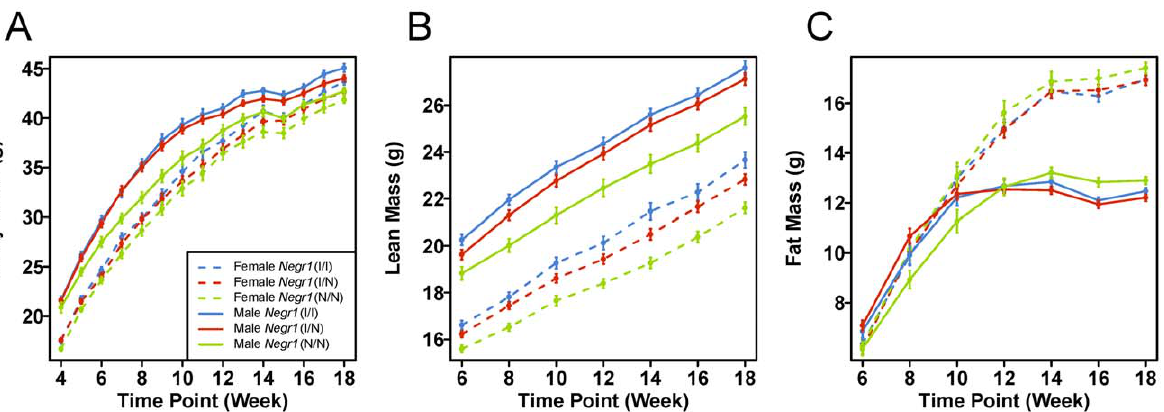
Figure 3. Negr1 -I87N mutants display altered body mass and composition. A–D . Body mass (A), Lean mass (B), fat mass (C) of wild type (female, n=28; male, n=22), heterozygous (female, n=52; male, n=51) and homozygous (female, n=28; male, n=24) Negr1 -I87N mice fed on high- fat diet measured across 18 weeks. Data shown are mean + / 2 SEM within each sex-genotype group at each time point.